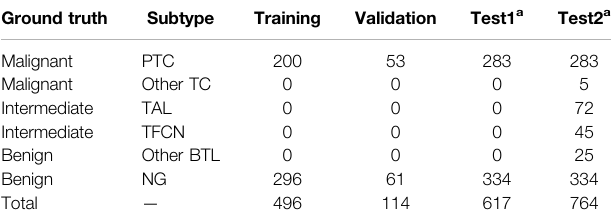
TABLE 2 | WSI counts for training validation and test